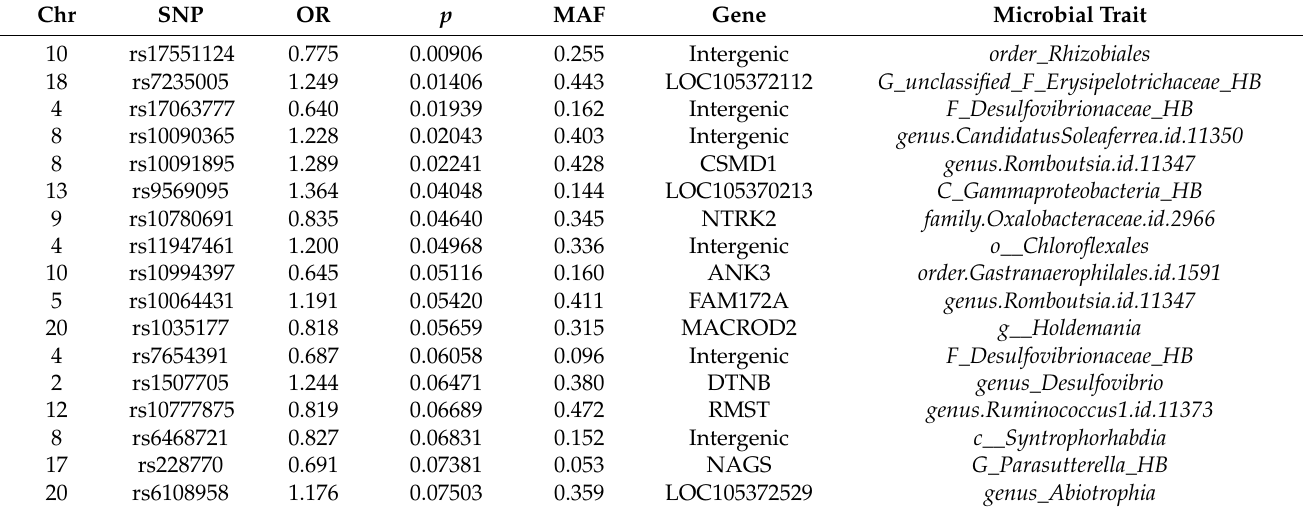
Table 3. Association between the top-ranked microbiota-related SNPs and type 2 diabetes in the whole population 1